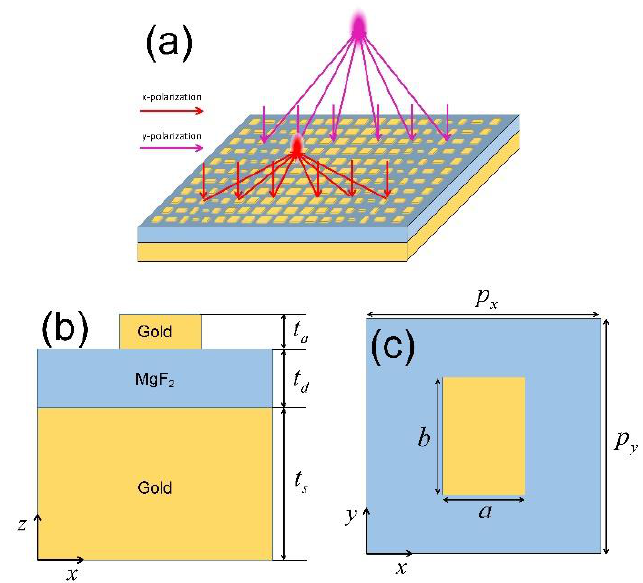
Figure 1. Schematic of the proposed metalens. ( a ) The fragment, ( b ) cross section view and ( c ) top view of the proposed metalens.